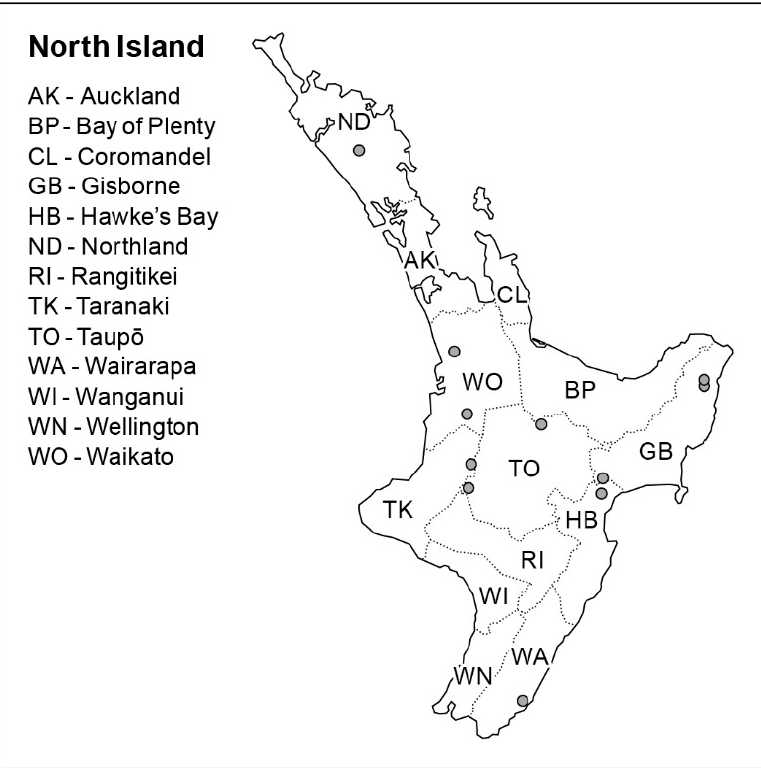
Figure 1. Distribution of Phytophthora podocarpi across the North Island of New Zealand. Grey dots indicate where the pathogen has been detected.